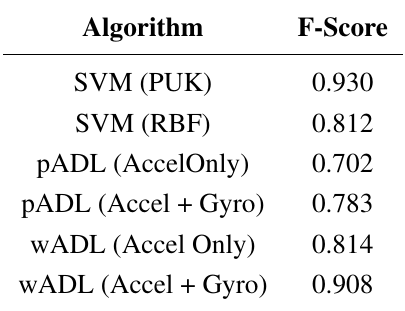
Algorithm [17] and the ADL algorithm with the gyroscope (all at 10 Hz) (phone then